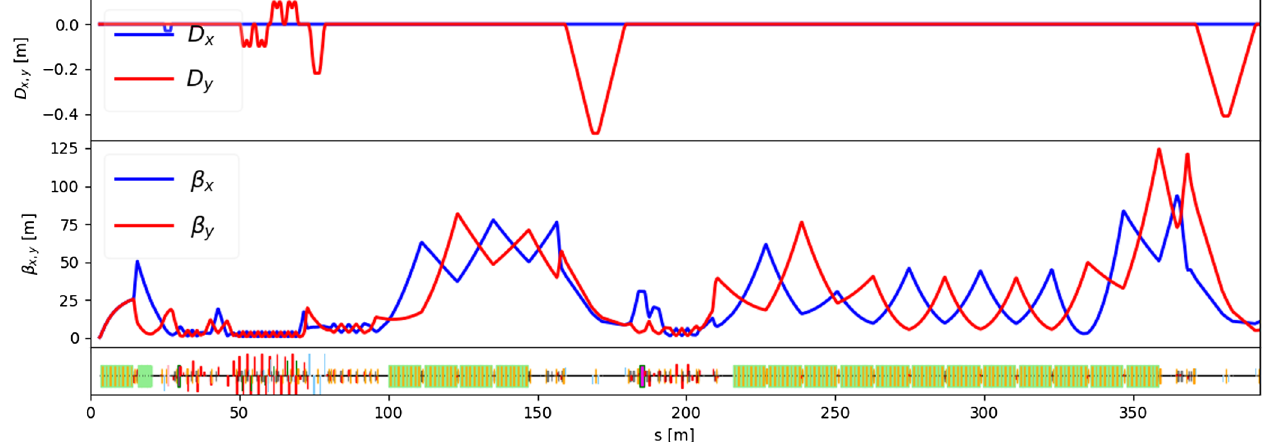
FIG. 2. The design optics of the European XFEL from the booster entrance ( z ¼ 3 . 2 m) up to the end of compressor BC 3 . The bottom plot presents an outline of different elements along the accelerator: rf modules (in green), quadrupoles (in red), etc.